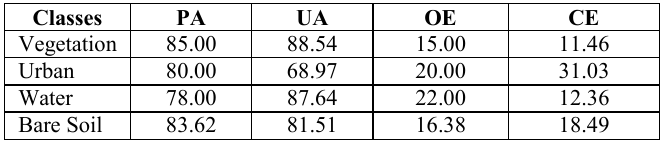
Table 5 Statistics derived through Maximum likelihood classification